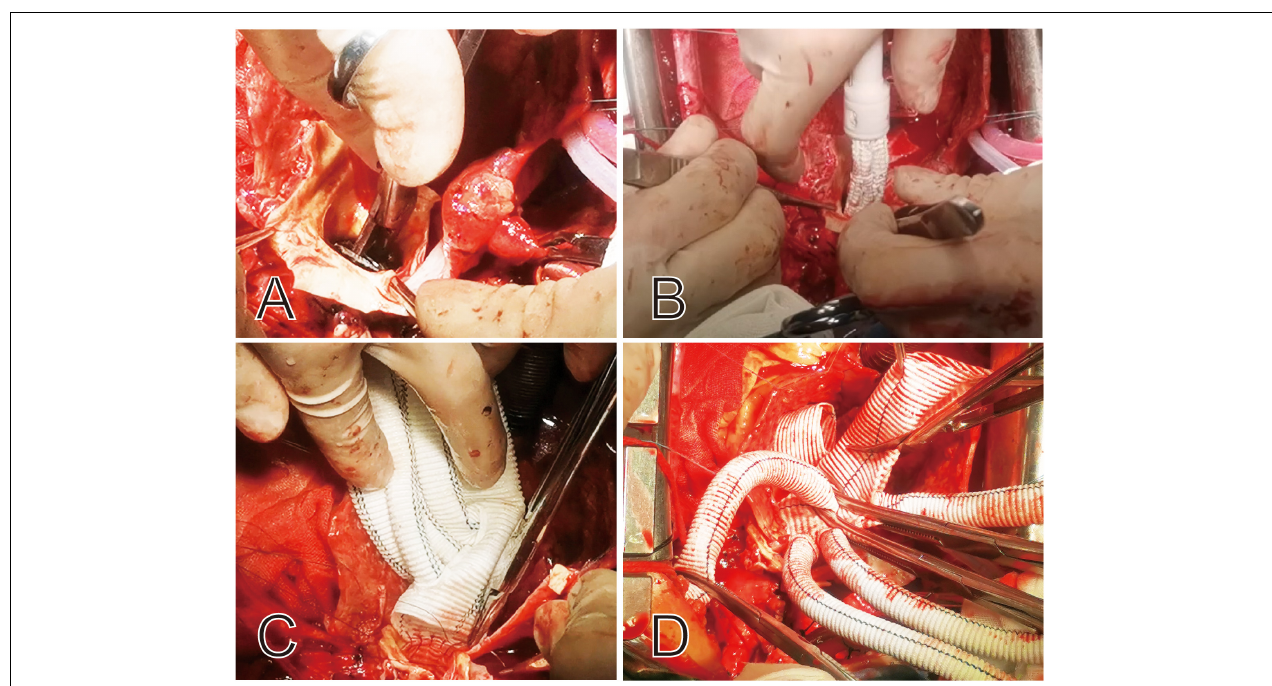
FIGURE 2 | Intraoperative view of the proximal portion of the deployed stent graft and the bare springs was cut off before completion of this anastomosis (A,B) . The proximal ends of the stent graft and aortic wall are sewn together to tetra-furcated graft (C,D) .